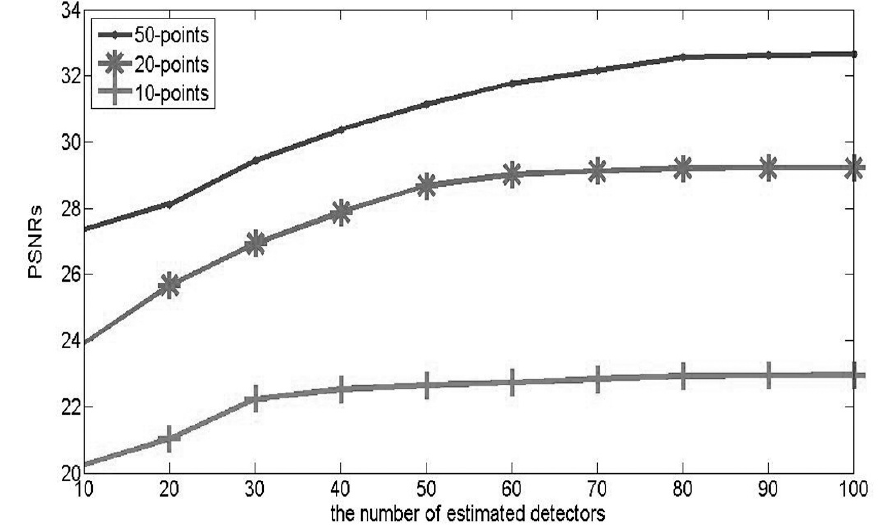
Figure 5. The line chart of the Peak signal-to-noise rations (PSNRs) (dB) versus the number of estimated detectors for the straight-line scanning for TV-GPEF.